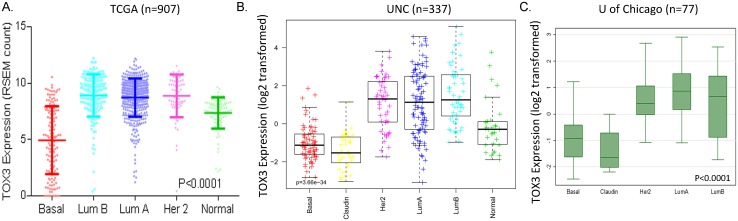
Subtype-specific expression of TOX3 in breast tumors.RNA sequencing (TCGA) and microarray results (UNC and U of Chicago) of TOX3 expression in breast tumors showed a significant difference in TOX3 expression among breast cancer subtypes, with TOX3 expression higher in luminal A, luminal B and Her 2 amplified tumors compared to normal breast epithelial tissues and basal-like tumors. (A) TCGA dataset (p<0.0001), RNA-seq data presented by RSEM (RNA-Seq by Expectation Maximization) normalized counts; (B) the University of North Carolina (UNC) dataset (p = 3.66e-34), microarray data presented by log2 transformed values; (C) the University of Chicago (U of Chicago) dataset (p<0.0001), microarray data presented by log2 transformed values.